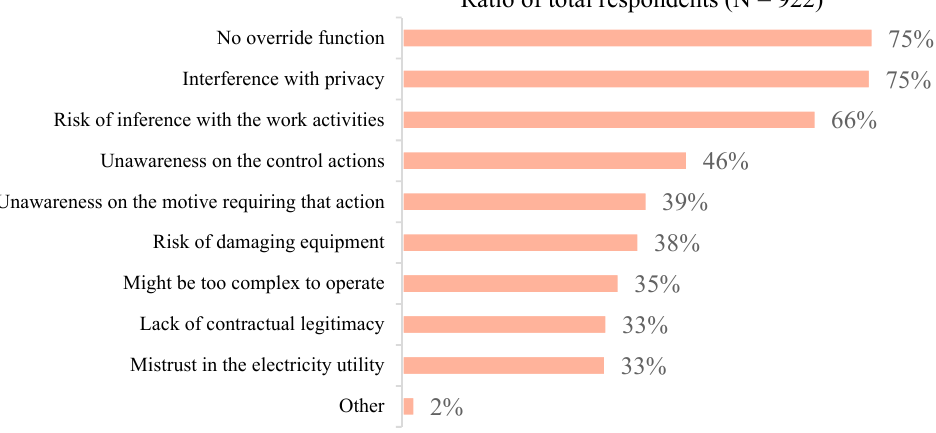
Figure 8. Reasons to not accept the remote control of some appliances by the electricity utility.